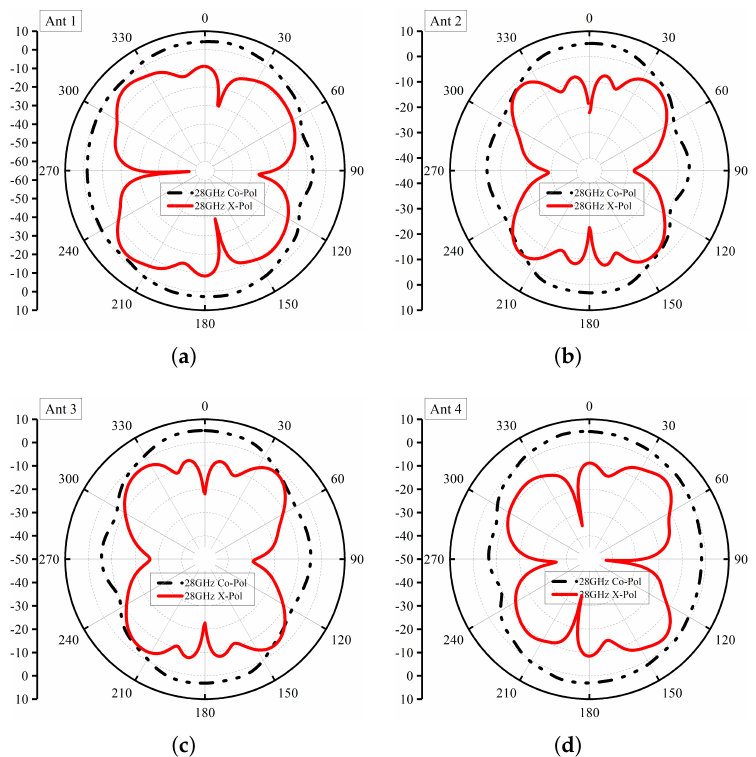
Figure 12. Co- and cross-polarization ( a ) Antenna 1 ( b ) Antenna 2 ( c ) Antenna 3 ( d ) Antenna